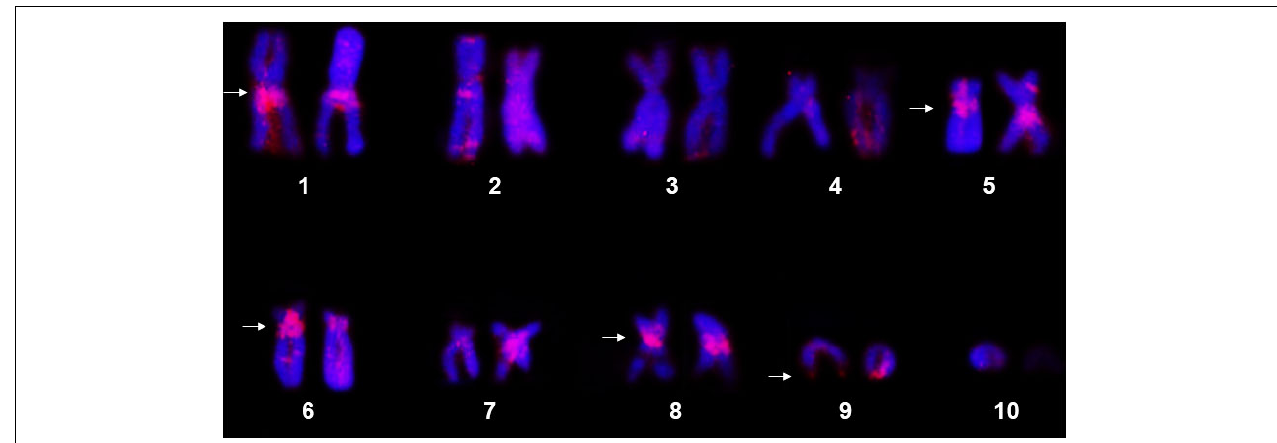
FIGURE 1 | Metaphase chromosomes of Pipa carvalhoi submitted to fluorescent in situ hybridization with the histone H3 probe. The chromosome pairs with hybridization signals detected in both chromatids of each homolog are indicated by the